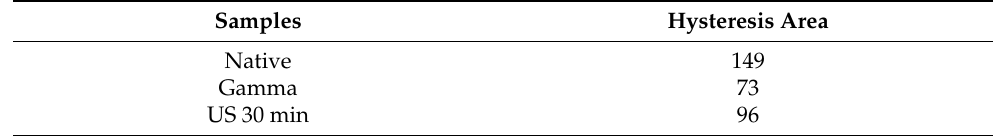
Table 2. Hysteresis area for the three different samples: Native, Gamma and US 30 min.